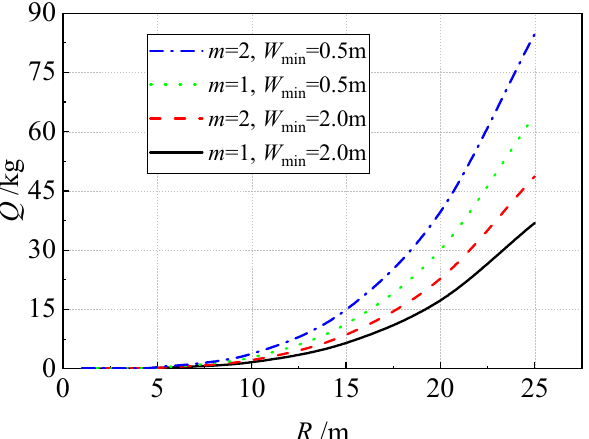
Figure 11. Control of safe charge.